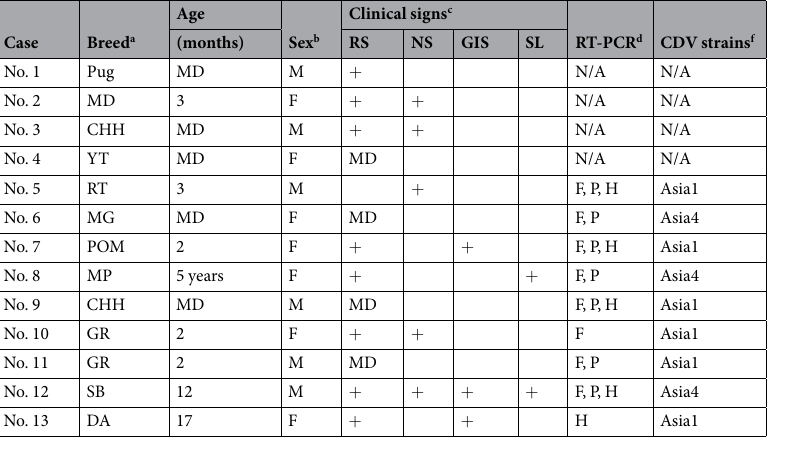
Table 1. General signalments and clinical signs of canine distemper virus (CDV) infected dogs. MD: missing data, N/A: not analyzed. a Breed: CHH: Chi huahua, YT: Yorkshire terrier, RT: Rottweiler, MG: Mongrel, POM: Pomeranian, MP: Miniature pincher, GR: Golden retriever, SB: Saint Bernard, DA: Dachshund. b Sex: M: male, F: female. c Clinical signs: RS: respiratory disorder, NS: neurological disorder, GIS: gastrointestinal disorder, SL: skin lesion. Data for nine dogs (Nos 5–13) were reported previously (Radtanakatikanon et al. ) 11 . d